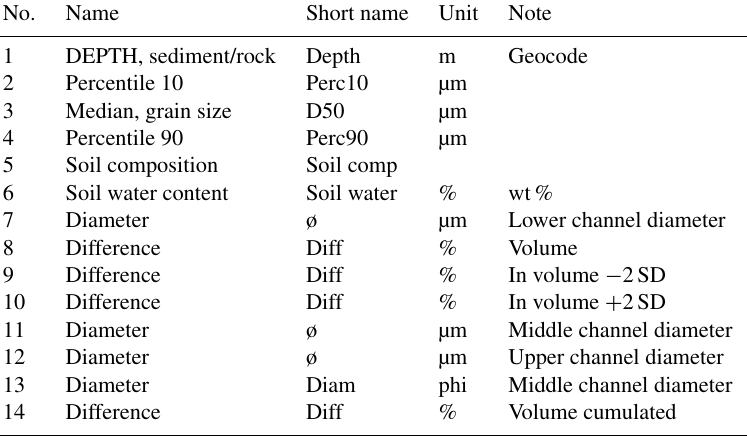
Table 3. Structure of the grain size analysis data sets at PANGEA (Lasser and Goehring, 2020b). Column names identify the depth at which each sample was collected; a lower (10th percentile), median, and upper (90th percentile) representative value of the grain size distribution; a general soil classification based on the most ubiquitous grain size range (following Chesworth, 2008); and the weight percentage of water in the soil sample. Column names also identify the lower channel diameter of the laser particle analyser (µm), the differential volume recorded in the respective channel, and the differential volume minus (plus) two standard deviations. Additionally, the middle and upper channel diameter (µm), the middle channel diameter in the Krumbein φ scale (Krumbein, 1934), and the cumulated differential volume are reported.